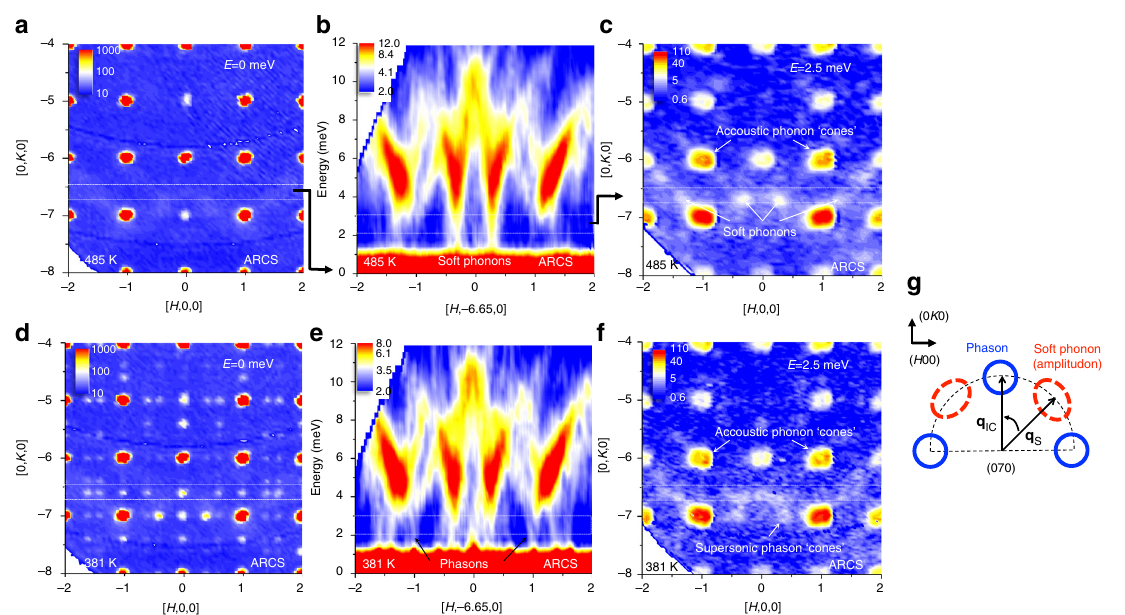
Fig. 2 Dynamic structure measured on a time-of- fl ight spectrometer. a Elastic slice ( E = 0 ± 0.5 meV) measured above the incommensurate transition temperature ( T C ~ 433 K) transition at 488 K in the ( HK 0) plane. b Inelastic scattering along Q = [ H , − 6.65, 0] showing soft optic modes at 488 K. c Constant energy slice ( E = 2.5 ± 0.5 meV) in the ( HK 0) plane at 488 K. d – f Show the same slices as a – c respectively, but measured below the transition at 381 K. g Illustration of the relationship between the phason wave vector, q IC , and the soft phonon (amplitudon) wave vector, q